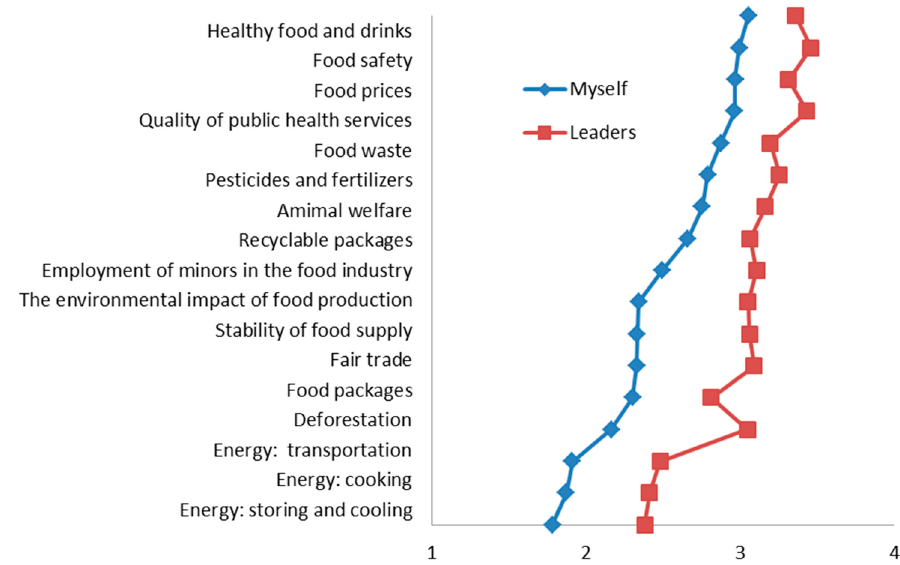
Figure 2. Perceptions of the importance of taking action on different aspects of food-related sustainability. Wilcoxon matched-pairs signed-rank test: all p < 0.0001 (for the difference between self and leaders).